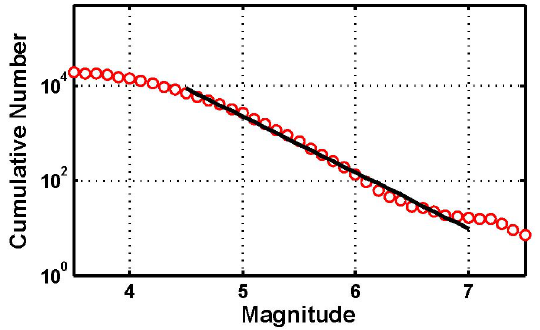
Fig. 5. Best fitting least-squares line though the IRIS catalogued (http://www.iris.edu/hq/retm) earthquake data set (January 2005 to December 2009), plotting cumulative number of earthquakes against Magnitude to estimate b -value in accordance with the G-R relation.